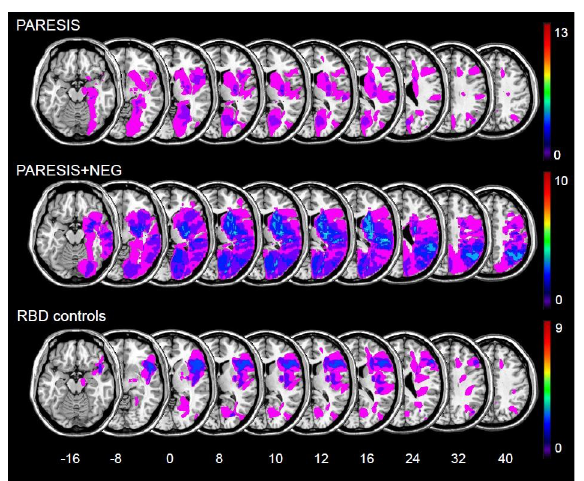
Fig 1. Simple lesion overlay plots of the three brain damaged subject groups (PARESIS, arm paresis without additional spatial neglect or anosognosia; PARESIS+NEG, arm paresis and additional spatial neglect but no anosognosia; RBD controls, stroke patients without arm paresis, without neglect and without anosognosia). The lesion maps are superimposed on the single-subject T1 MNI152 template. The figure shows the vertical z coordinate for each slice of standardized MNI space. For each voxel, the number of patients with a lesion at that location is color coded (n = 1 to max.).